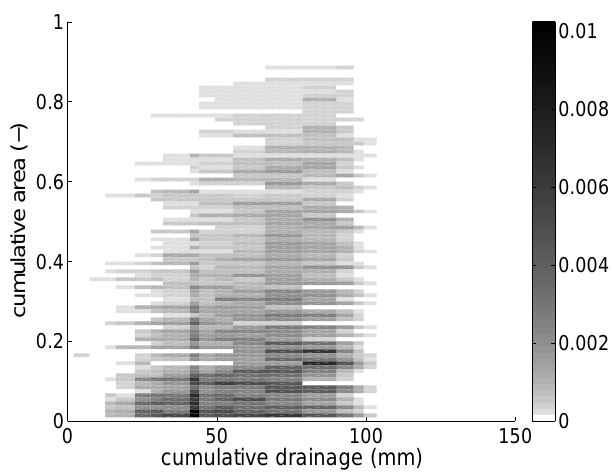
Fig. 3. Scaled solute flux density (d − 1 ) for bromide for the snowmelt experiment.